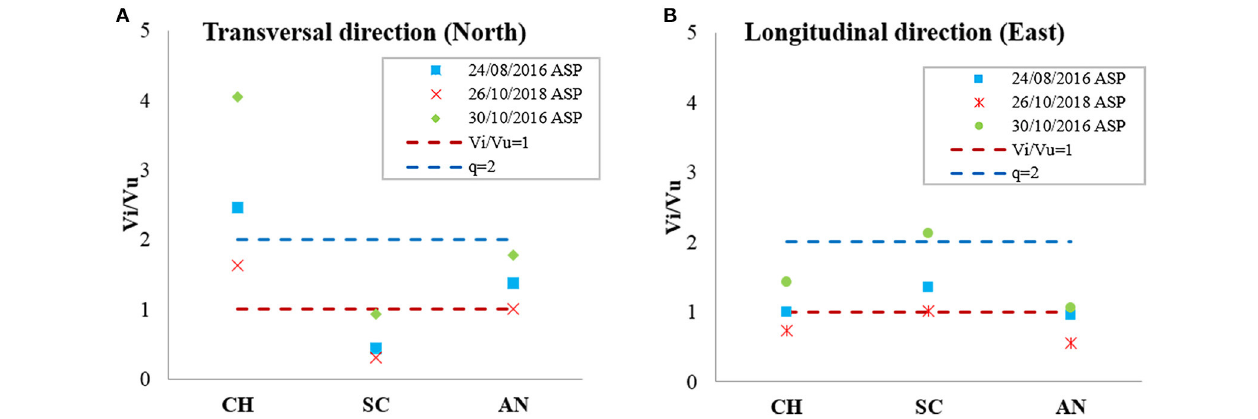
FIGURE 13 | Horizontal seismic demand (Vi) to horizontal strength capacity (Vu) ratio for different macro-elements of the church for the Model CS for transversal (A) , and longitudinal directions (B) .